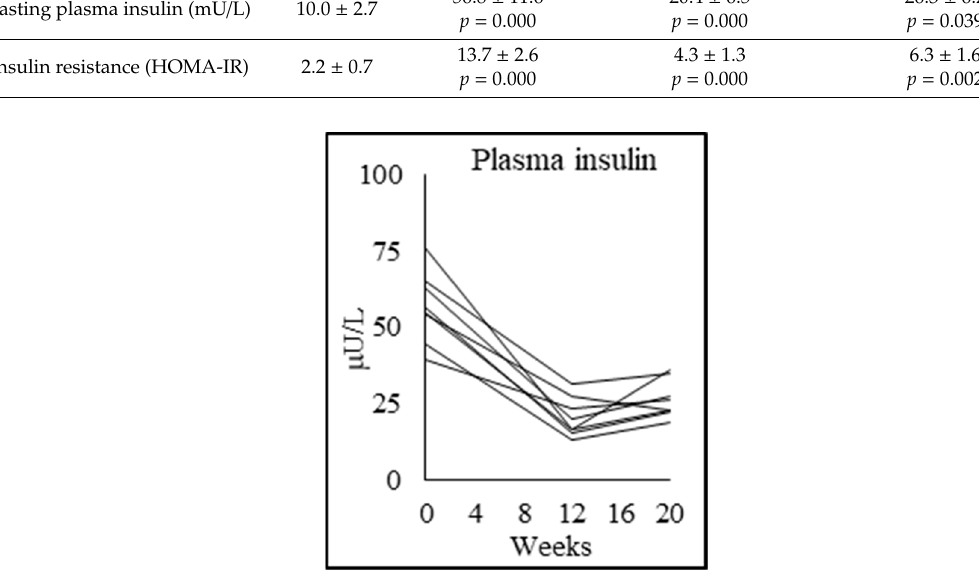
Figure 3. Individual participant data showing fasted plasma insulin concentrations.